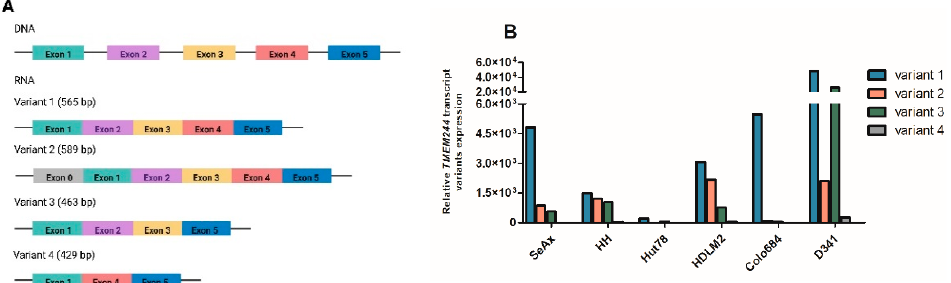
Figure 5. TMEM244 transcript variants identified with RACE method. ( A ) Transcript variant length